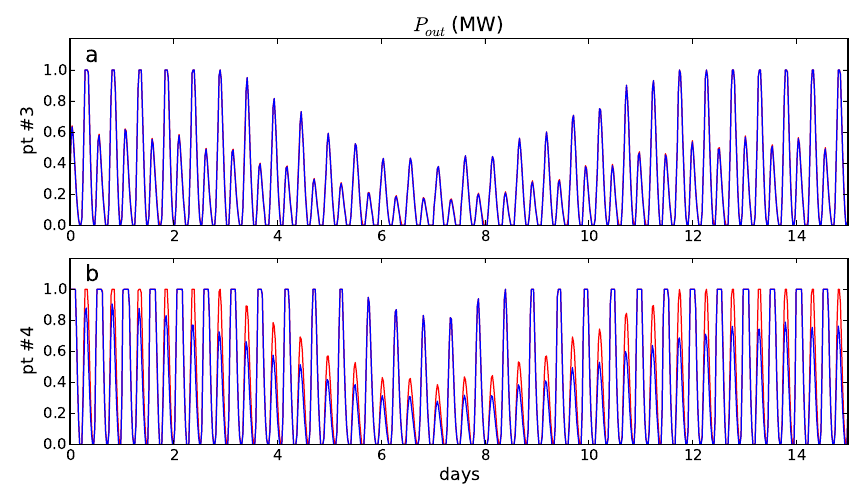
Figure 10. Generated practical power at 10 m above the seabed from a 1 MW turbine with fixed axis (blue line) and a yaw (red line) at Points #3 ( a ) and #4 ( b ) in spring-neap conditions (Figure 9).